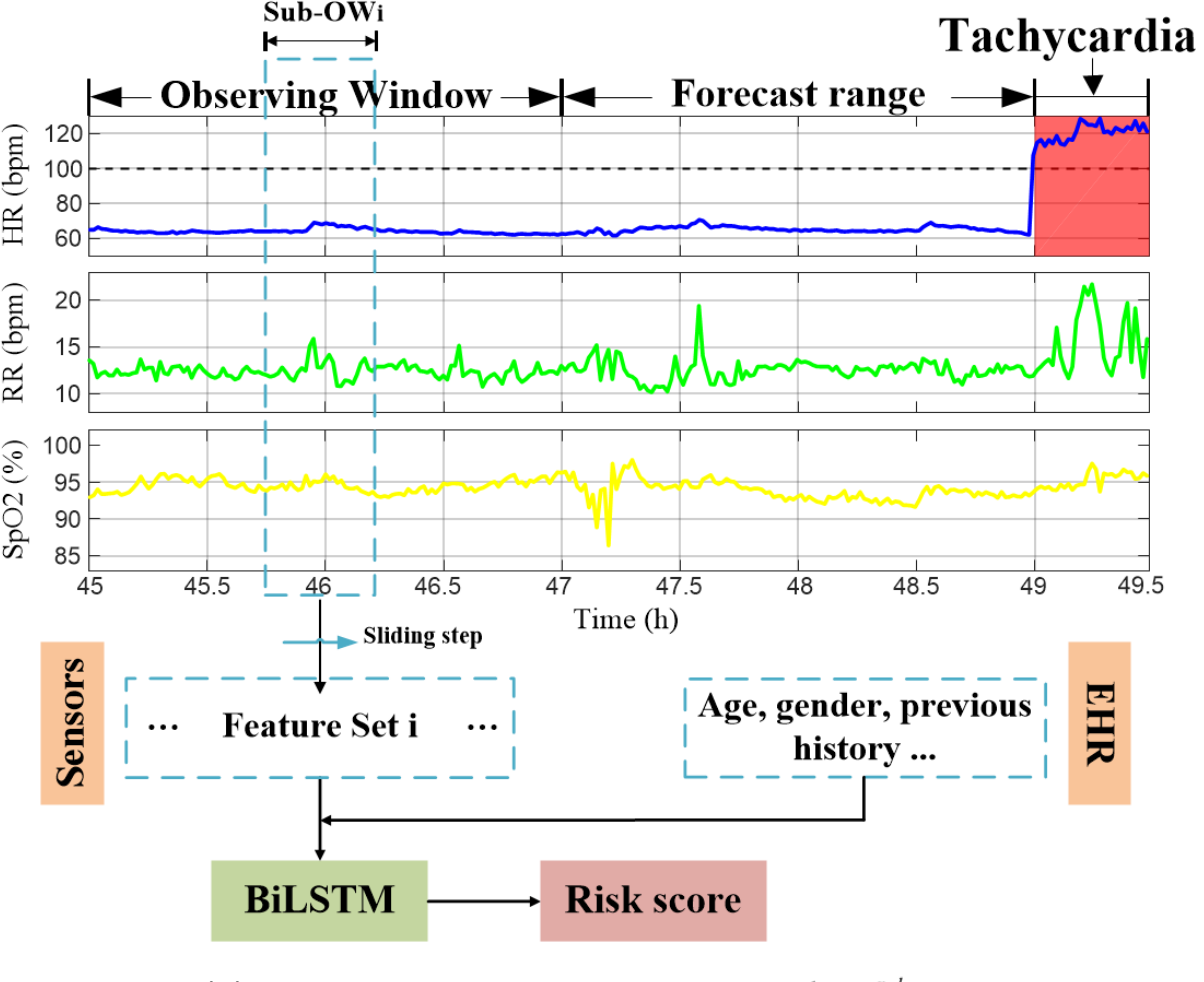
Figure 2. An overview of TOP-Net using the cohort admission and personal measurement data in hospital. BiLSTM: bidirectional long